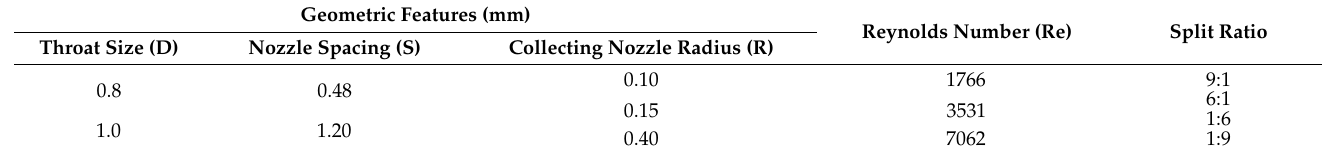
Table 2. Sampler detail